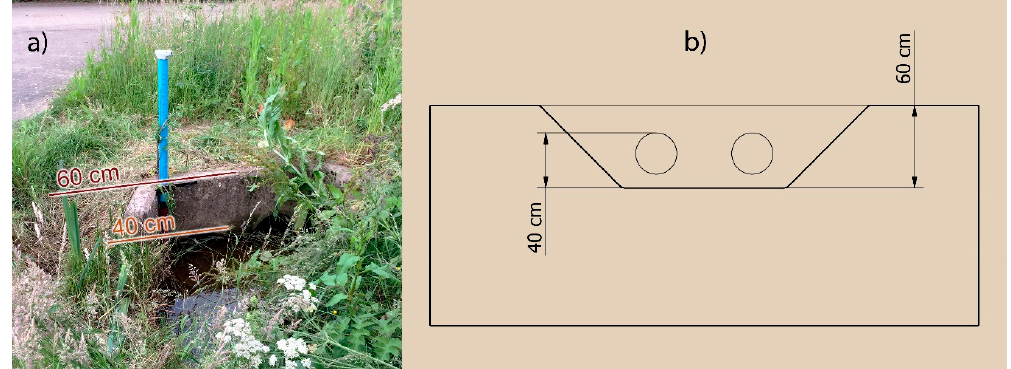
Figure 3. Water levels of hydraulic failure indicated at the discharge point ( a ) and its cross section ( b ). Storm events were isolated by using 6 h slots where no rainfall was recorded over 2.5 mm values